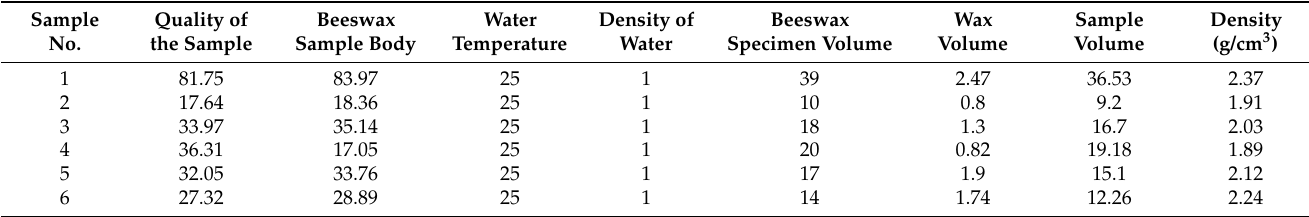
Table 2. Wax seal method density experiment on six